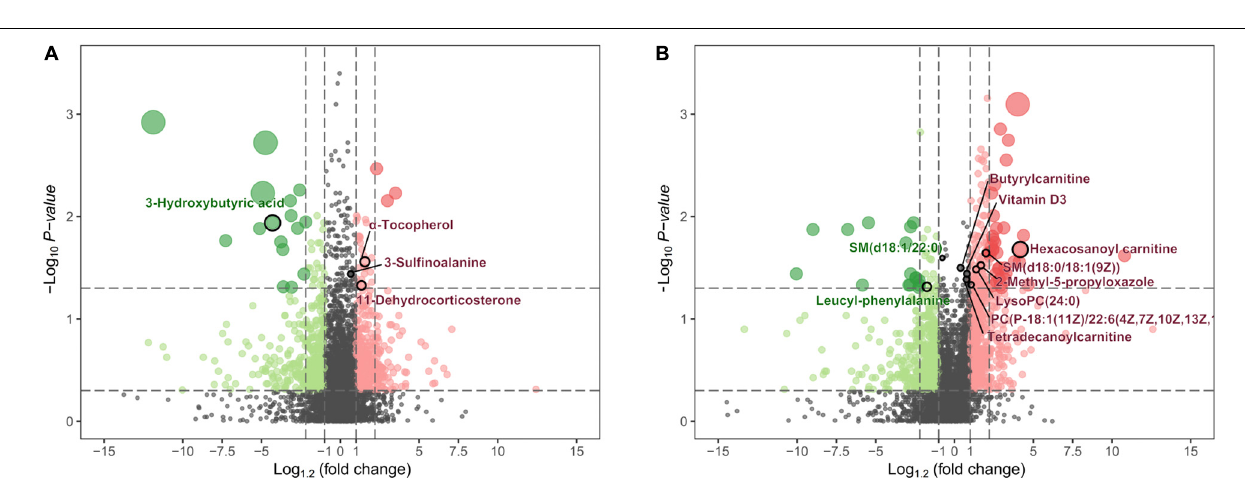
FIGURE 7 | The volcano map shows the p -values, fold changes, and VIP-values of all metabolic characteristics. The color green indicates decreasing expression, and red indicates increasing expression. The spot size reflects the corresponding VIP-value. The major metabolites are highlighted in the maps. (A) Metabolite characteristics of the UHPLC-QE-MS (+) model. (B) Metabolite characteristics of the UHPLC-QE-MS (–)